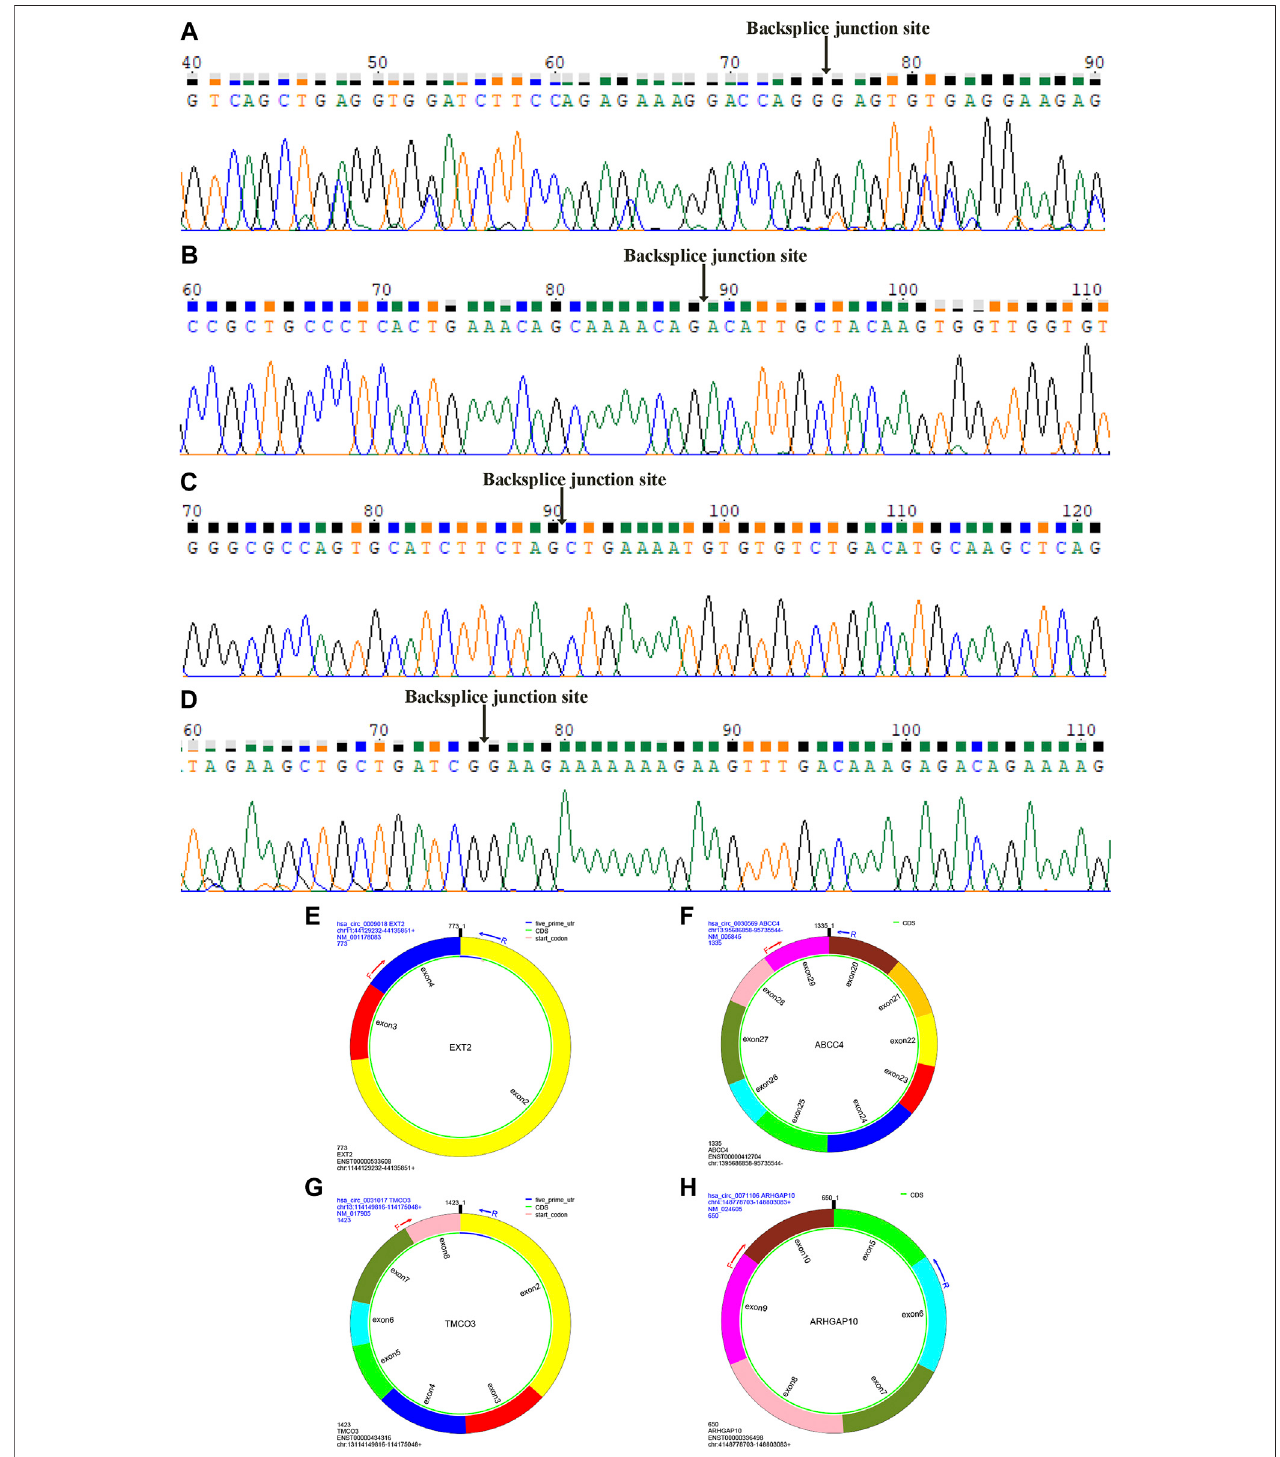
FIGURE 9 | Sanger sequencing identi fi ed circRNAs backsplice junction sites. The backsplice junction sites of hsa_circ_0009018 (A) , hsa_circ_0030569 (B) , hsa_circ_0031017 (C) and hsa_circ_0071106 (D) . The structure and qRT-PCR primer positions of hsa_circ_0009018 (E) , hsa_circ_0030569 (F) , hsa_circ_0031017 (G) and hsa_circ_0071106 (H) .